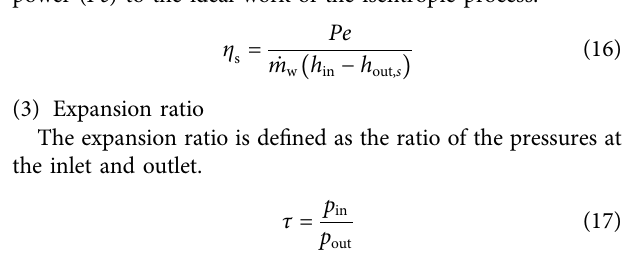
TABLE 3 | Parameters of working fl uids at different experimental